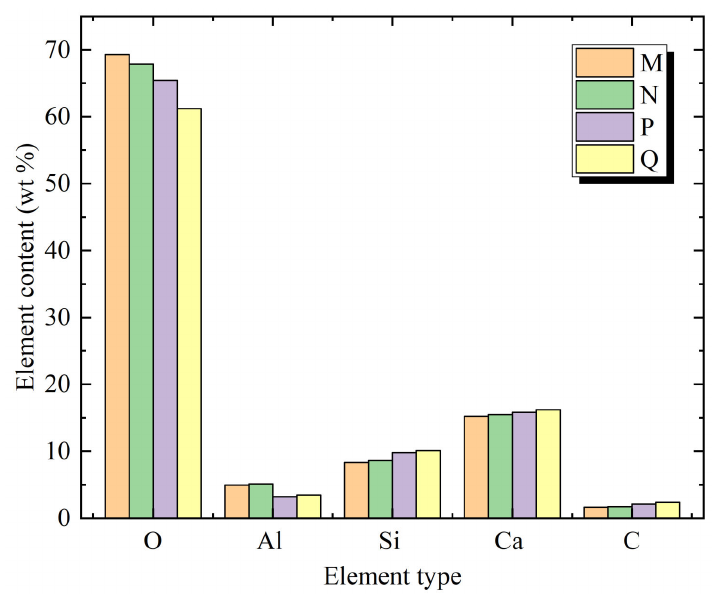
Figure 10. Comparison of EDS elements in different regions of concrete specimen